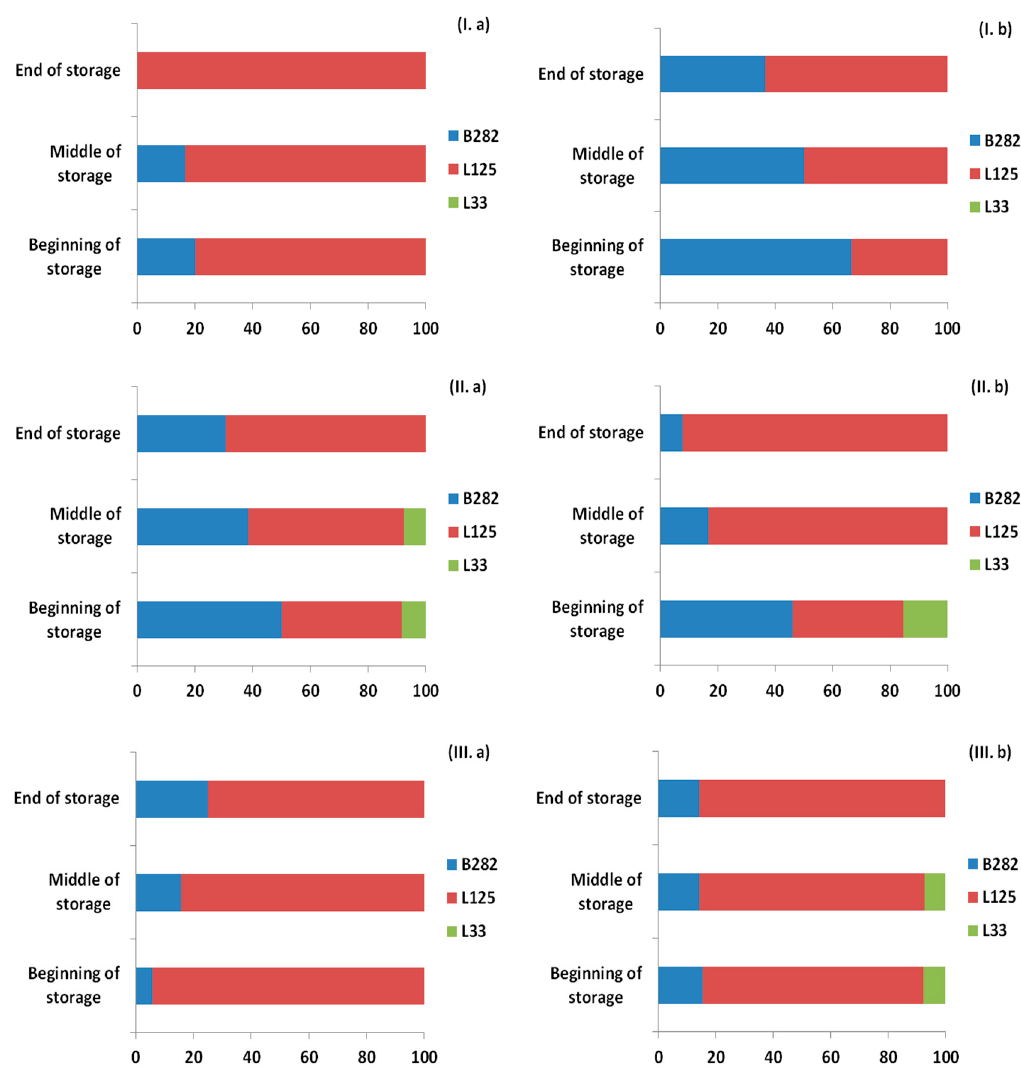
Figure 5. Distribution of isolates (%) of probiotic strains recovered from ham slices in three time points (beginning, middle and end) during storage at: 4 °C ( I ); 8 °C ( II ); and 12 °C ( III ); and ( a ) without HPP; or ( b ) with HPP treatment based on the pulsed field gel electrophoresis (PFGE) profiles.